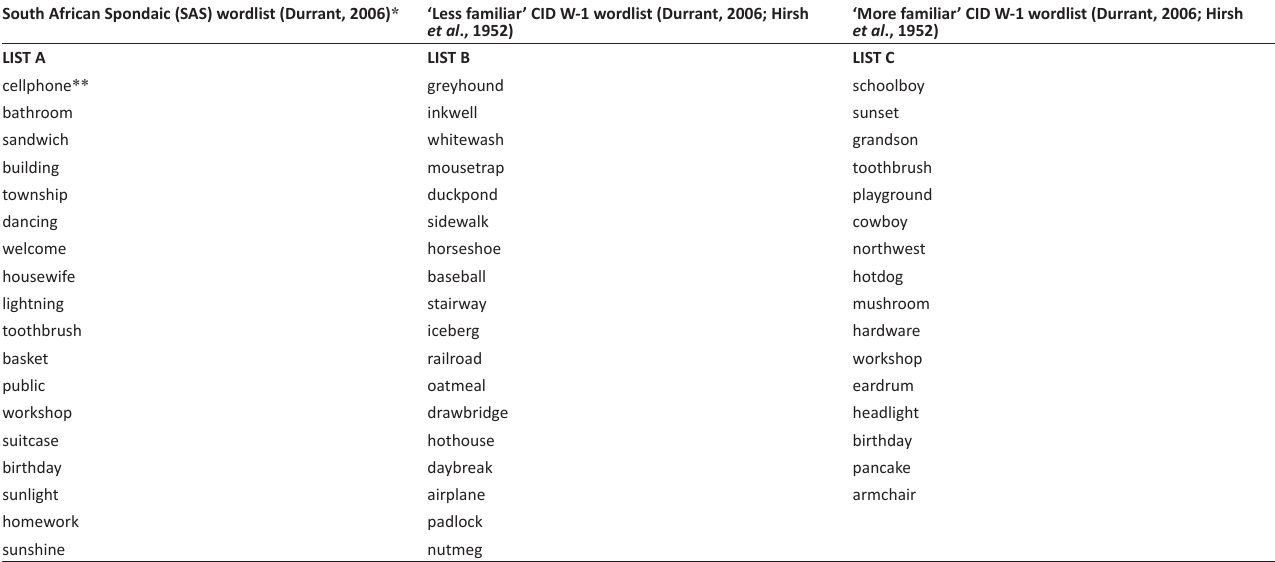
TABLE A1-1: Available spondaic wordlists in terms of